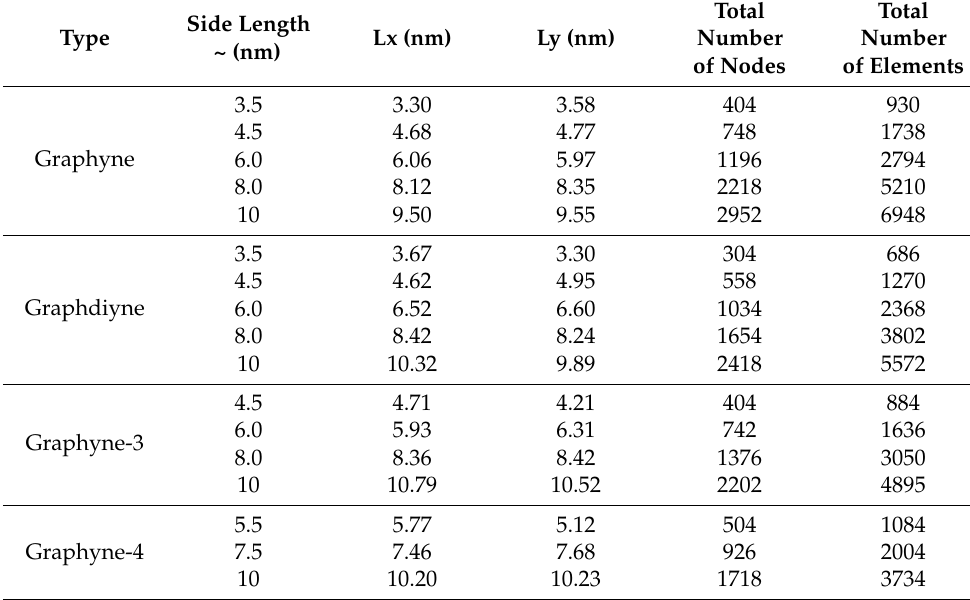
Table 1. Information regarding the utilised FEM